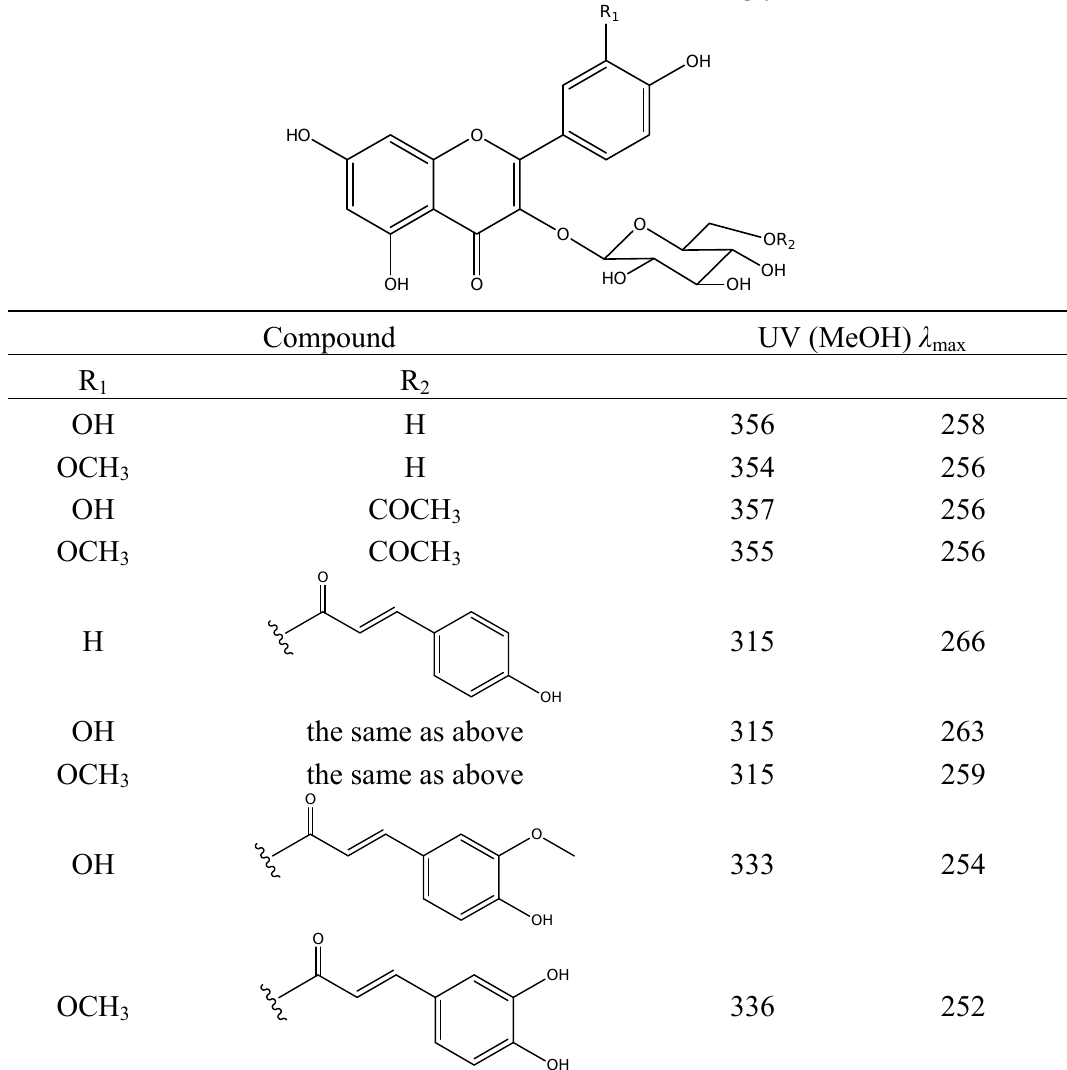
Table 2. The UV data for different flavonol